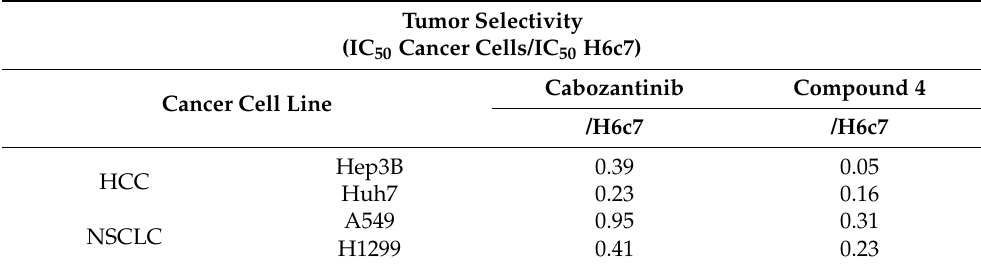
Table 3. Tumor selectivity indices of cabozantinib and compound 4